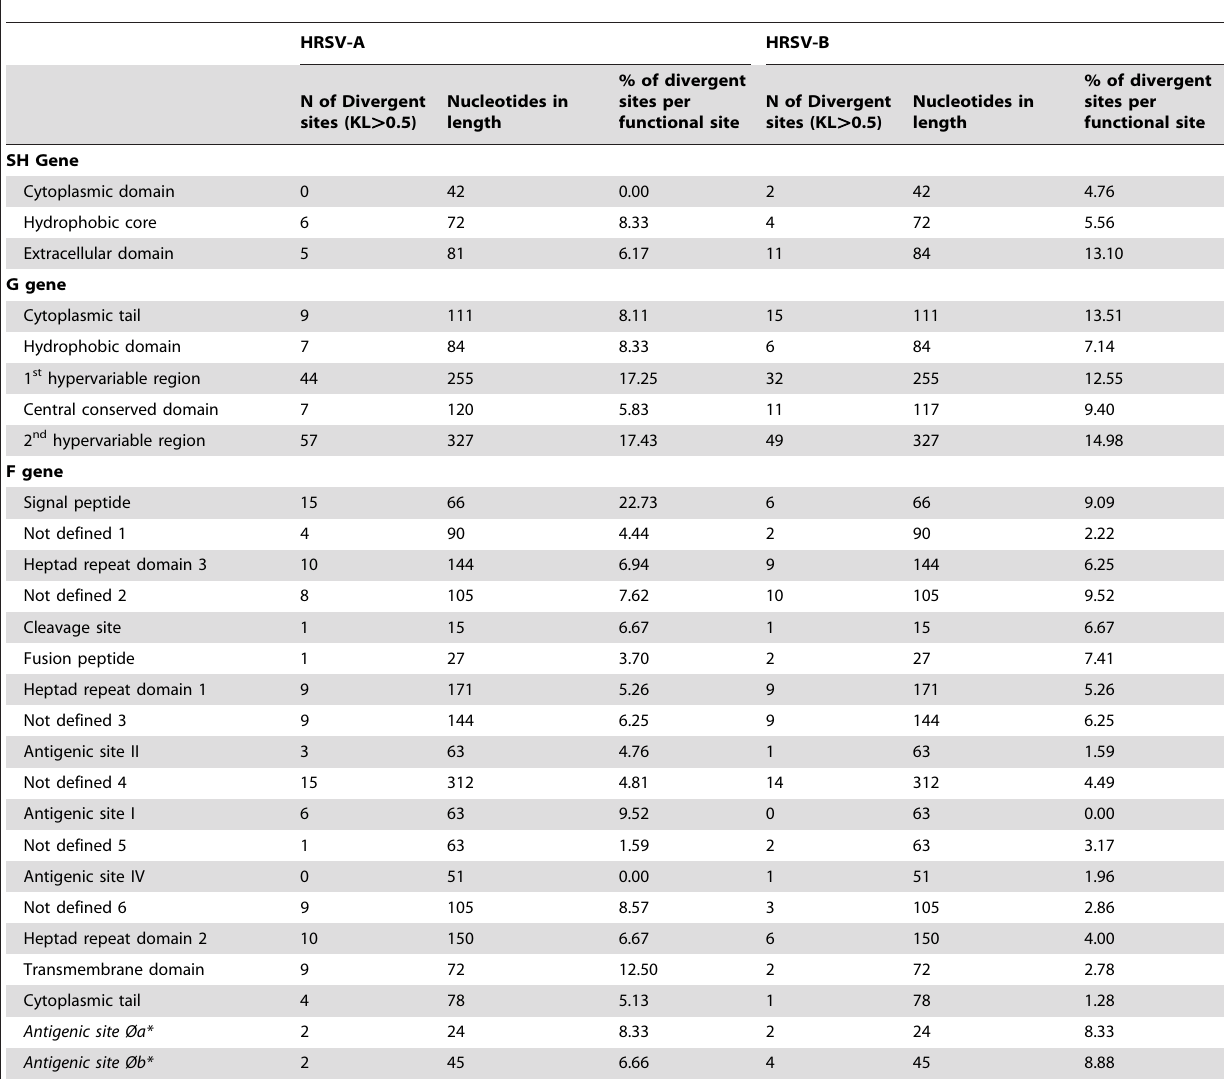
Table 2. Nucleotide variability of the major domains of the SH, G and F genes that encode the three surface proteins of HRSV of the Texas isolates compared to the prototype viruses.